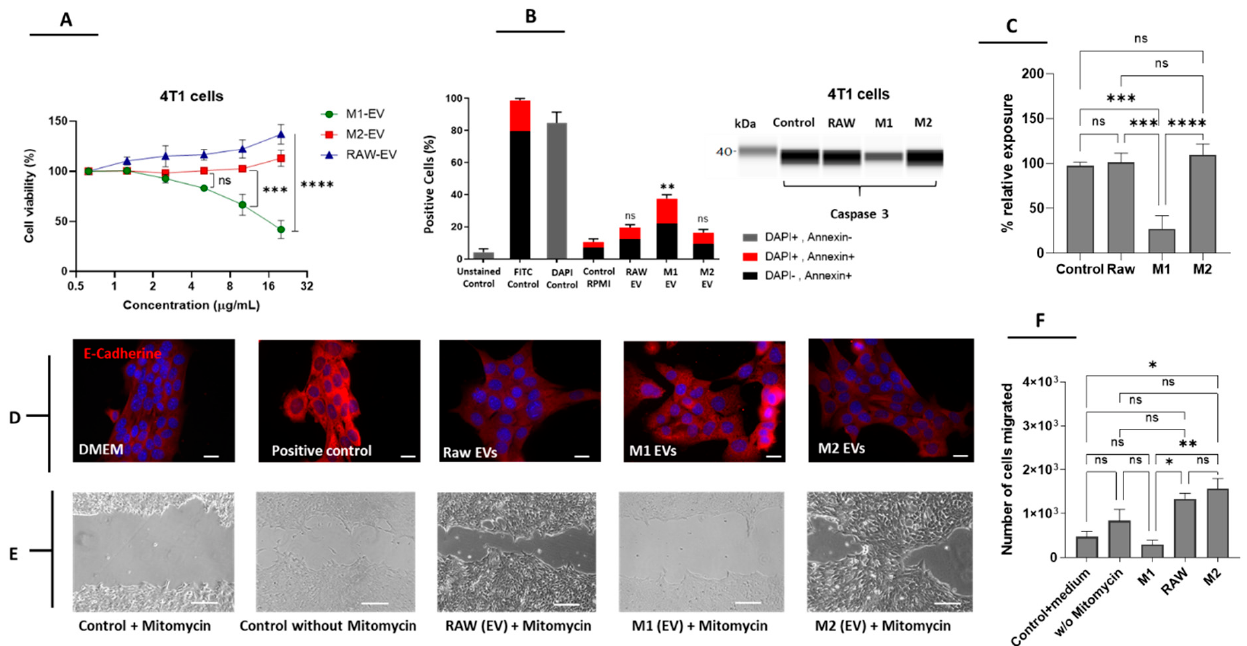
Figure 2. In vitro effects of macrophage-derived EVs on proliferation and migration of 4T1 cells. ( A ) An MTS assay to investigate the effect of M1, M2, and RAW-EVs on cell viability. ( B ) Annexin V-FITC/DAPI double staining was used to evaluate apoptosis induction in response to the EVs. ( C ) Western blot analysis of caspase 3 integrity in cells treated with the three types of EVs ( left ) and relative exposure ( right ). ( D ) Immunofluorescence analysis of E-Cadherin expression in response to EVs (Scale bars are 20 µ M). ( E ) Wound-healing assay in the presence of mitomycin to verify the effect of EVs on cell migration (Scale bars are 200 µ M). ( F ) Quantification of migrating cells in the wounded area. Data are means ± SEM ( n = 3). Non-significant (ns); **** p < 0.0001; *** p < 0.001; ** p < 0.01; * p < 0.05 (vs. control unless